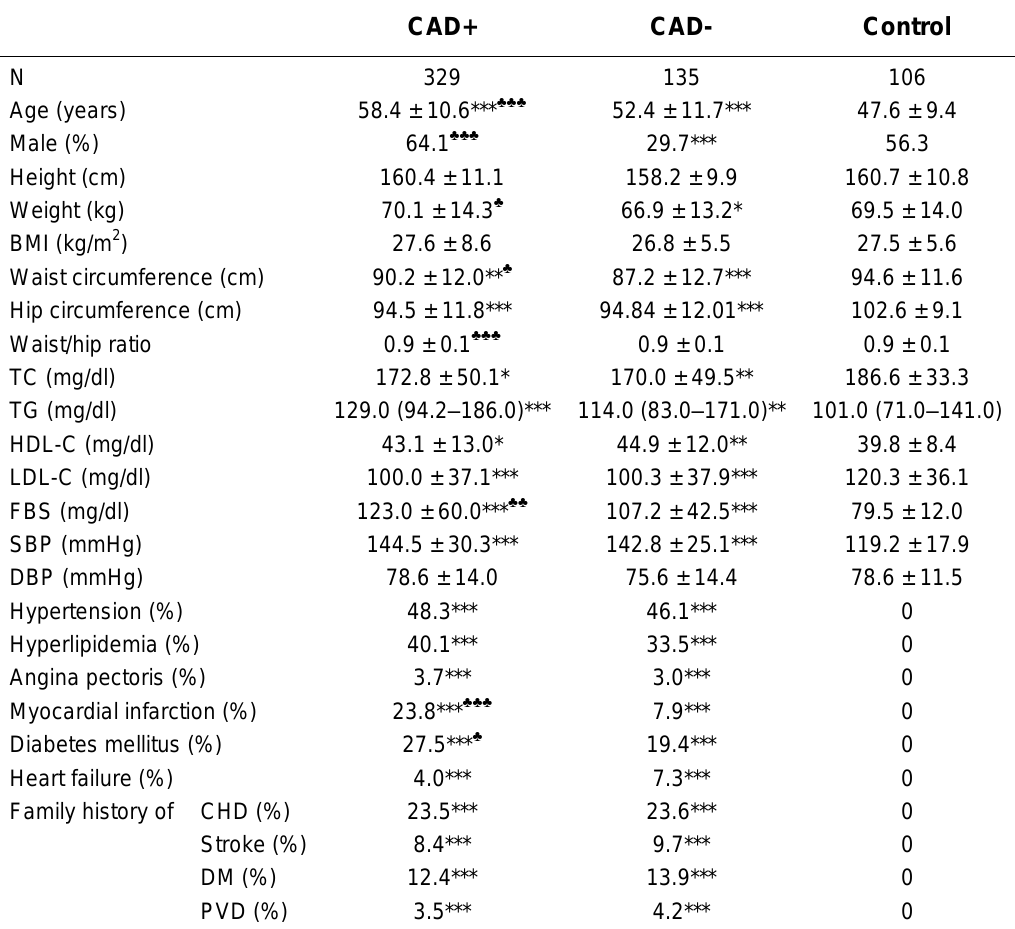
General Characteristics of CAD+, CAD-, and Control